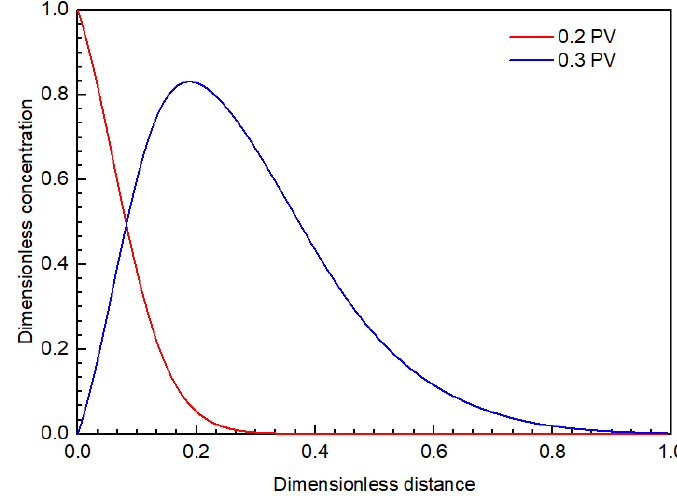
Figure 15. Concentration of polymer solution along the flow.